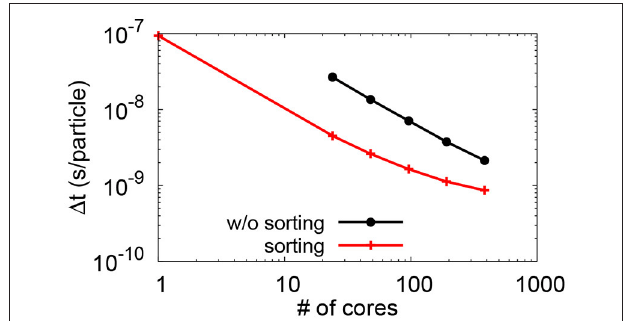
FIGURE 2 | Particle pusher computation time per macroparticle (per time-step) as a function of the number of computing cores, with (red solid line) and without (black) particle sorting. Simulations use 20 particles-per-cell, 1 MPI thread per socket and a 256 × 96 × 96 3D grid, and are run on 24 cores Intel Xeon processors (E5-2697 v4, 46M cache, 2.3 GHz), with 2 sockets per node for a total of 48 cores per node. The number of OpenMP threads is